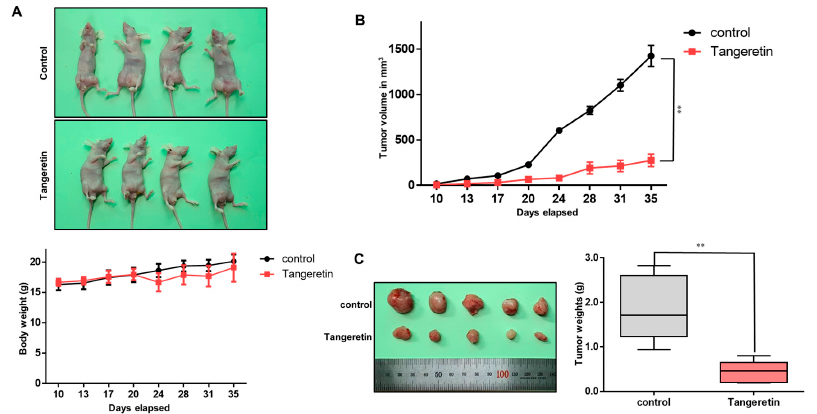
Figure 5. The effect of tangeretin on tumor growth in a xenograft model. ( A ) MDA-MB-231 cells (2 × 10 6 cells/mouse) were inoculated into the mammary fat pad of female nude mice and treated with tangeretin (2.5 mg/kg) or DMSO (n = 6). Nude mice were intraperitoneally injected with/without Tangeretin (2.5 mg/kg) once a week for a total of four time injections. The body weights of the tangeretin-treated group were comparable to those of the control group. ( B ) Tumor volume was calculated as (width 2 × length)/2 at the indicated time points. ( C ) The tumor weights of the control and tangeretin-treated mice were assayed after sacrifice at day 35. The data are presented as the mean ± SD of three independent experiments. ** p < 0.05 versus the DMSO-treated control